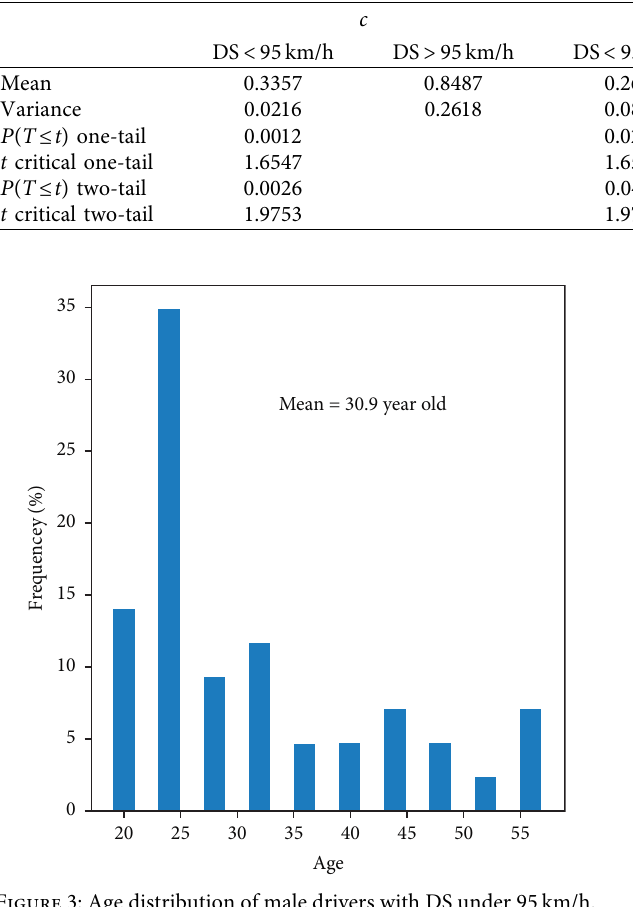
Table 3: Two-sample t -test of CF parameters of the model between the men groups categorized based on DS.